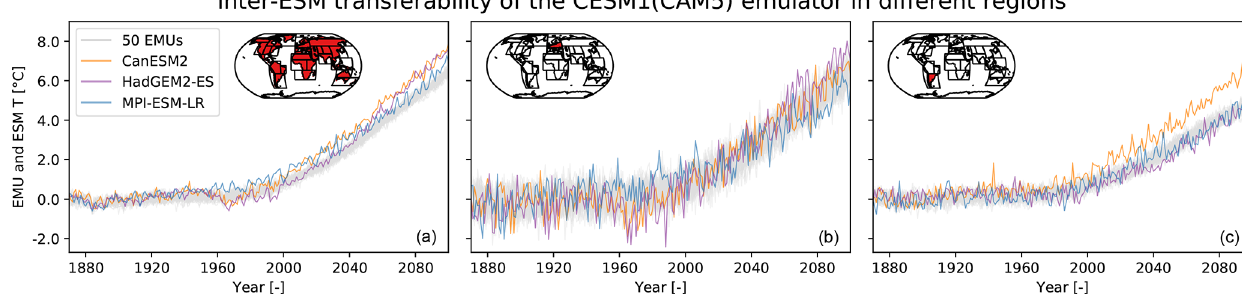
Figure 7. Emulator properties (rows) of the 40 CMIP5 climate models (columns). (a) For the global mean temperature module, T and the AR coefficients plus the standard deviation of the innovations of T glob , var t are depicted. (b) For the local temperature response module, the regression coefficients are shown. (c) For the local residual variability module, the lag-1 AR coefficients, the standard deviations of the innovations, and the localization radii are displayed. Box plots indicate the median (dark gray line), the interquartile range (gray box), and the full range of values (gray